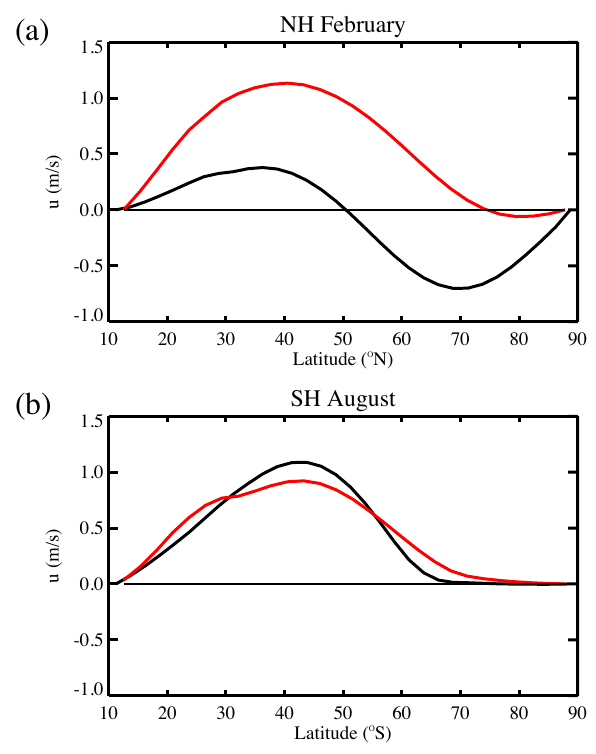
Fig. 9. Zonal mean zonal wind response to CO 2 doubling (doubled CO 2 run minus the control run), obtained from inverting the stratospheric PV between 400 K and 1250 K (in m s − 1 for the UM model (black lines) and the ECHAM model (red lines) at 400 hPa as a function of latitude, for (a) February in the NH and (b) August in the SH.